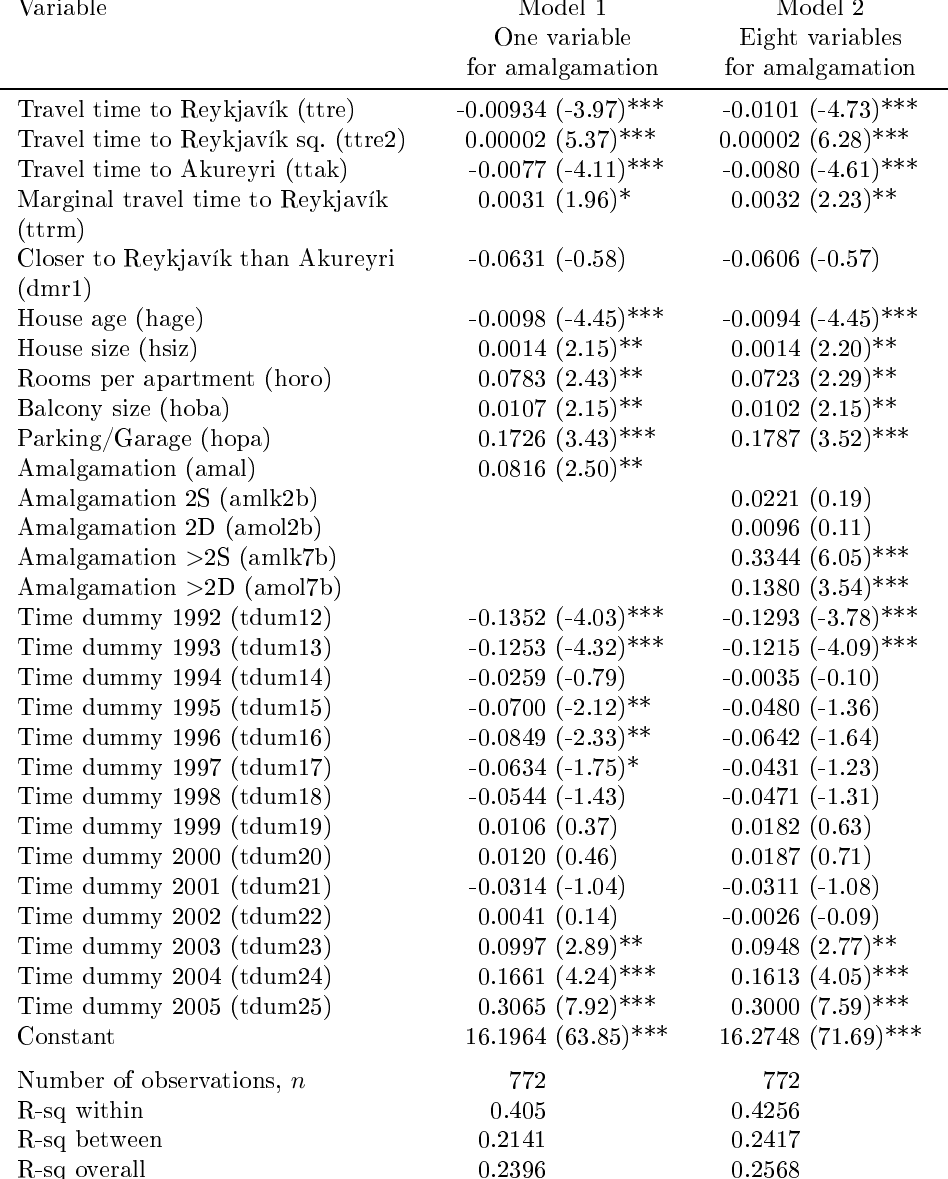
Table 3: Relationship between housing prices and amalgamation (cid:21) A polycentric model in semi logarithm of a quadratic distance version; data sample 1992-2006 Variable Model 1 Model 2 One variable Eight variables for amalgamation for amalgamation Travel time to Reykjav(cid:237)k (ttre) -0.00934 (-3.97)*** Travel time to Reykjav(cid:237)k sq. (ttre2)